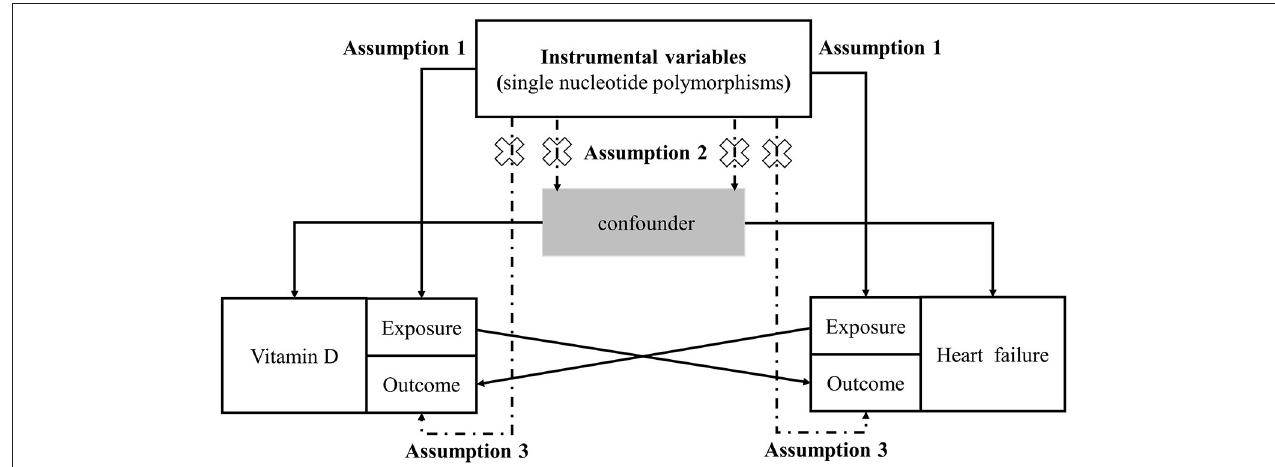
FIGURE 1 | Study design flowchart of the Mendelian randomization study. The Mendelian randomization method is based on three hypotheses: (1) the instrumental variables is closely related to exposure; (2) instrumental variables is independent of any confounding factor; (3) instrumental variables affects the results only through exposure but not through other